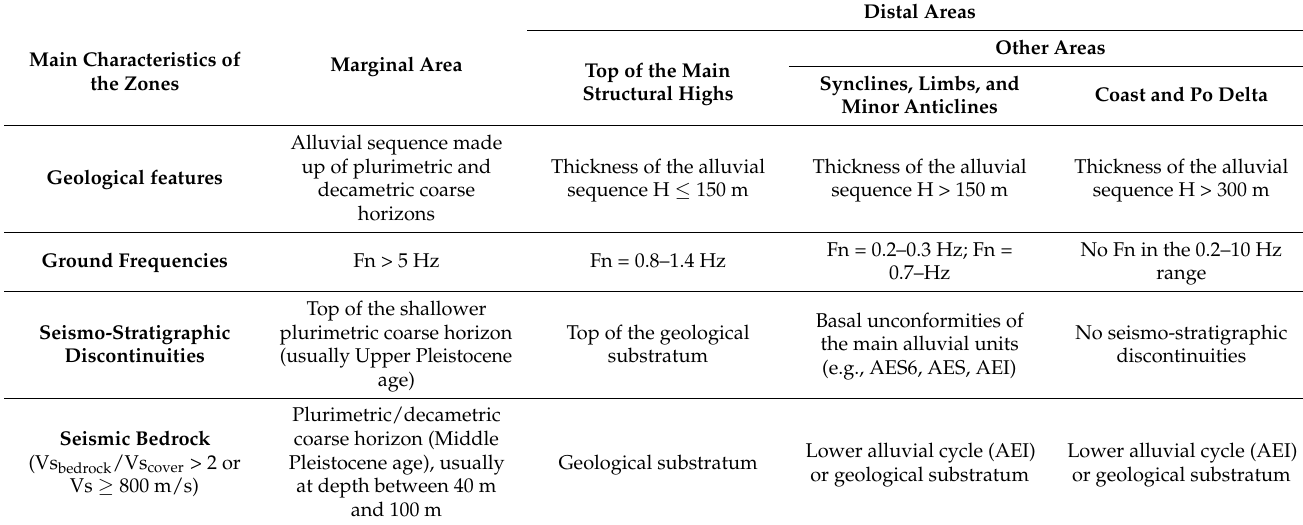
Table 2. Main geological and geophysical characteristics of the Emilia-Romagna